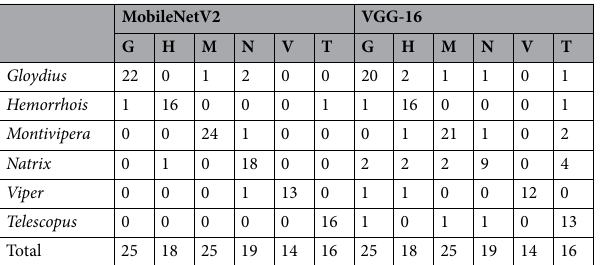
Table 3. Confusion matrix showing the performance of MobileNetV2 and VGG-16 model for snake image classification of the test dataset. Total number of the samples has been presented bellow each